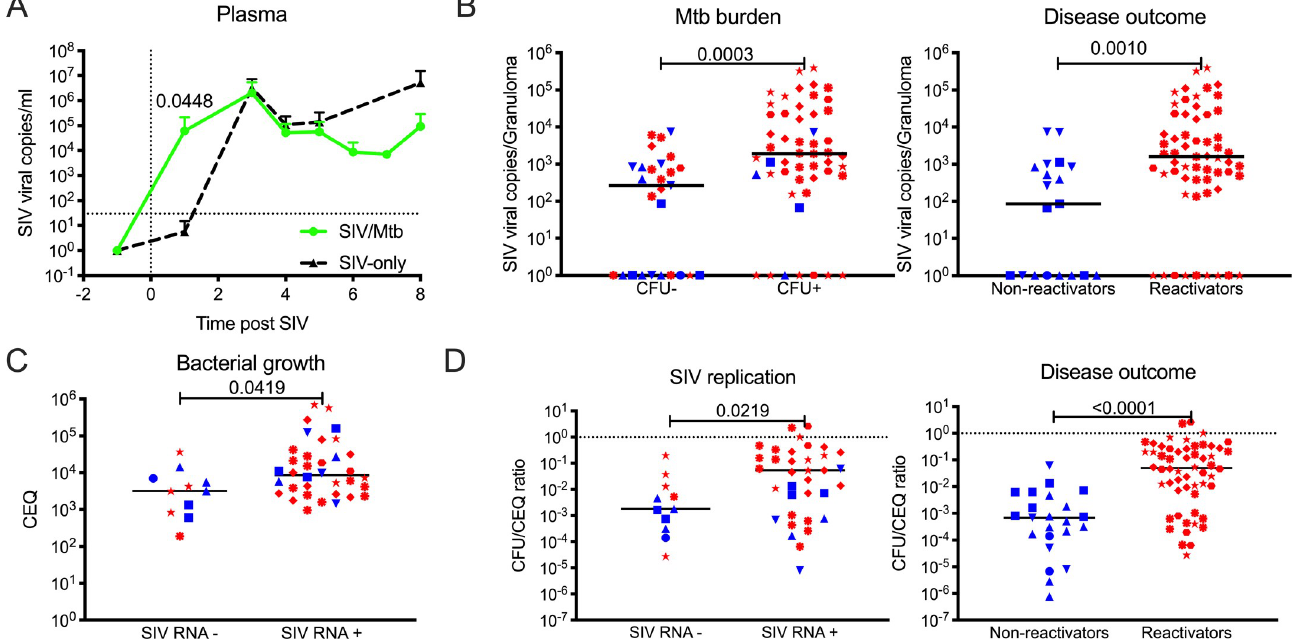
Fig 6. SIV replication within the granuloma is associated with reactivation status, greater bacterial burden and growth with less bacterial killing. A) Comparison between plasma SIV RNA copies/ml from SIV-only (black, n = 4) and Mtb/SIV co-infected (green, n = 8) NHP. Symbols represent means and error bars represent standard deviations. B) Differences in SIV RNA replication within lung granulomas from Mtb/SIV co-infected NHP by Mtb burden (Mtb growth [CFU+, n = 51] and sterile [CFU-, n = 27]) and outcome (reactivators [red, n = 59] and non-reactivators [blue, n = 19]). Each symbol is a granuloma. C) Bacterial growth (presented as chromosomal equivalents, CEQ) is greater within among Mtb/SIV granulomas with detectable SIV RNA (SIV-, n = 11; SIV+, n = 35). D) Within Mtb/SIV NHP granulomas, less bacterial killing (represented as CFU/CEQ ratio) is observed when SIV RNA is present (SIV-, n = 11; SIV+, n = 35) and during reactivation (reactivators [red, n = 56] and non-reactivators [blue, n = 23]). CFU was transformed by adding 1 to reflect sterile lung granulomas with CEQ. Dotted line at Y = 1 defines no killing. Two points above Y = 1 represent the higher CEQ threshold (1000) compared to CFU’s lower threshold (10). Each shape represents an individual NHP. Individual t tests were utilized to determine significant differences (P < 0.05) between SIV-only and Mtb/SIV NHP. The Mann- Whitney test was used to determine significance between groups in granulomas. Lines represent medians in B-D.